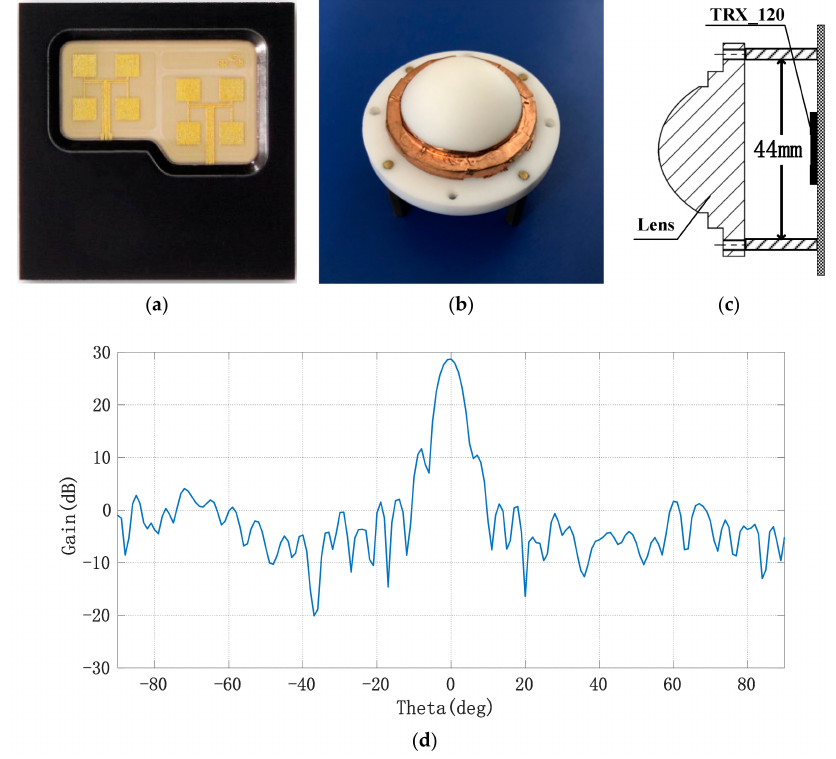
Figure 4. Millimeter wave lens antenna and its far-field pattern; ( a ) layout of millimeter wave radar’s transmitting and receiving antennae; ( b ) picture of the lens; ( c ) assembly diagram of narrow beam lens; ( d ) far-field pattern of lens